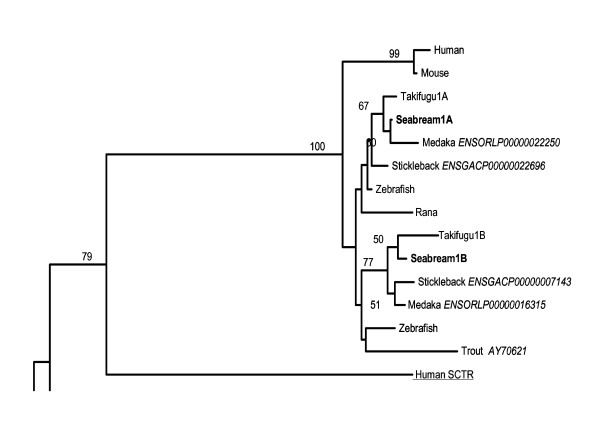
Phylogenetic analysis of the vertebrate PAC1 members. This figure represents the upper quartile of the consensus tree, for full image and details please refer to Additional file 2. Sea bream PAC1 receptors are in bold and the novel teleost PAC1 receptors identified are refereed by their Ensembl nomenclature. PAC1 accession numbers are: Human, P41586; Mouse, P70205; Rana, Q90Y07; Takifugu1A, AJ494861, Takifugu1B, AJ490804; zebrafish1A, NM_001013444 and zebrafish1B, XM_701685.